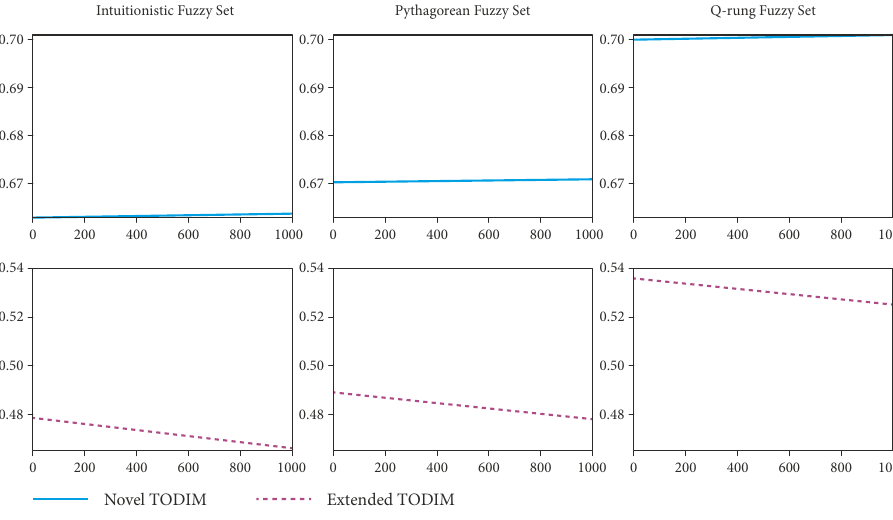
Figure 1. The sensitivity analysis results of A 2 (1.25 < l ≤ 2.25)